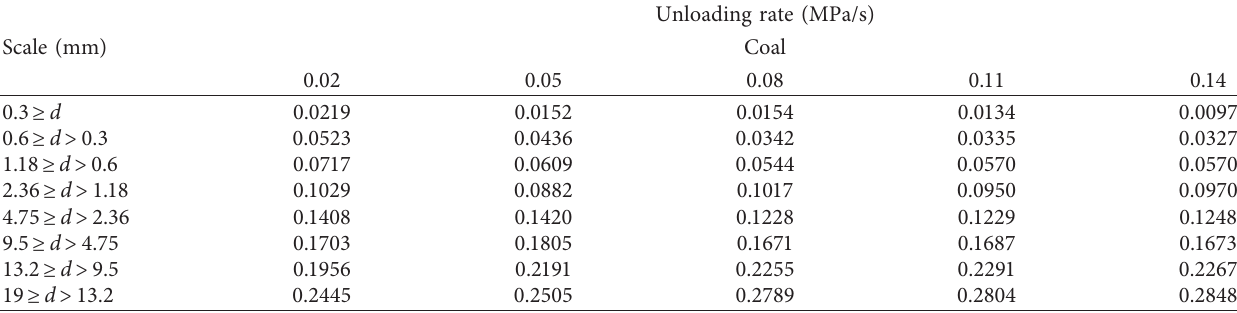
Table 6: Mass fractions of fragments at different scales in the coal sample under different unloading rates.